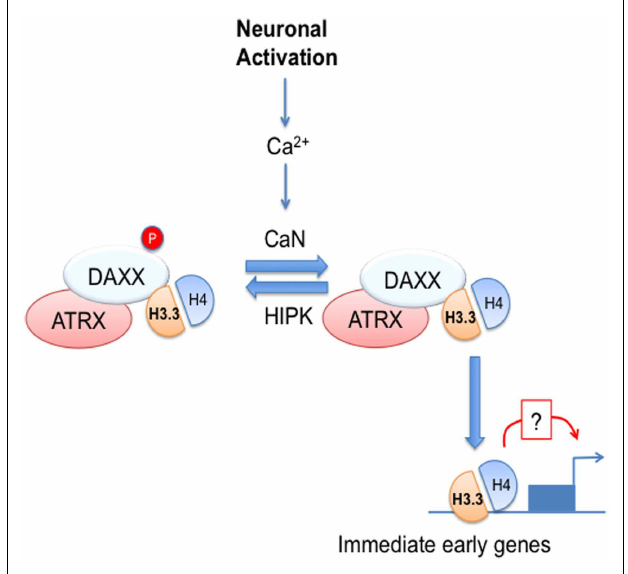
FIGURE 1 | DAXX chaperone activity is regulated by calcium-dependent signaling in neural cells . Neuronal activation leads to calcium (Ca 2 + ) entry and activation of the Ca 2 + -dependent phosphatase, calcineurin (CaN). In turn, CaN dephosphorylates DAXX at serine 669, leading to increased H3.3 loading at selected immediate early genes (IEGs). DAXX loss not only affects H3.3 loading, but also leads to impaired induction of IEGs, thus suggesting that H3.3 loading may modulate IEG transcriptional